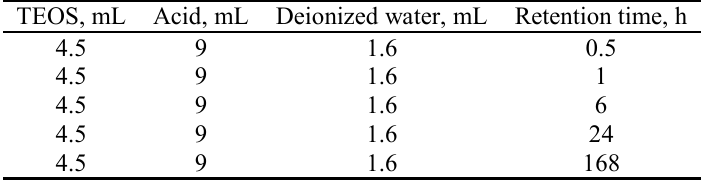
Table 5. Change the retention time of sol-gel